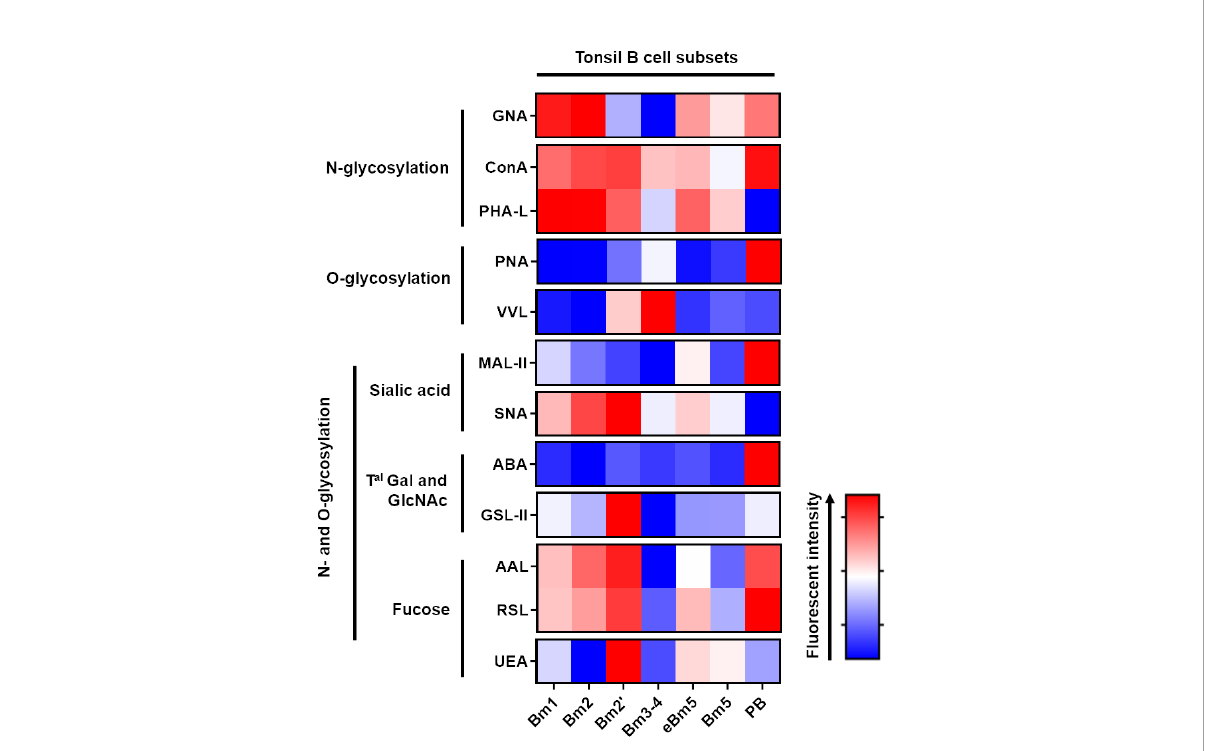
FIGURE 3 Tonsillar B cell maturation process is associated with an important N- and O-glycan remodeling. Freshly isolated tonsillar mononuclear cells were stained with lectins and the speci fi c B cell antibody panel before analysis using Beckman Coulter Cyto fl ex S. Fluorescence intensity is expressed as geomean. Freshly isolated tonsillar mononuclear cells were stained with lectins (Table